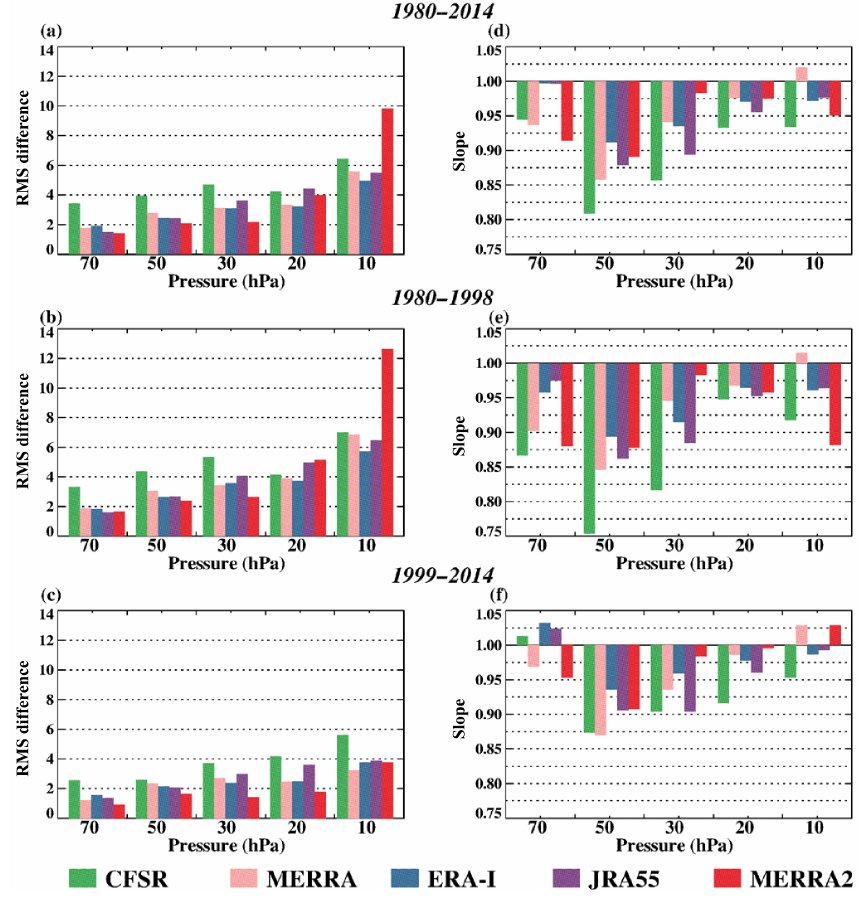
Figure 10. RMS differences (ms − 1 ) (a–c) and linear slopes (d–f) of the matched QBO zonal wind anomalies at 70, 50, 30, 20, and 10hPa for the CFSR, MERRA, ERA-I, JRA-55, and MERRA-2 reanalyses interpolated to Singapore (1 ◦ N, 104 ◦ E) vs. the observed Singapore monthly mean zonal winds from the FUB. RMS differences and slopes are computed for the 1980–2014 time period (a, d) , the 1980–1998 period (b, e) , and the 1999–2014 period (c, f) . Slopes less than 1.0 indicate that the reanalysis zonal winds are weaker than the Singapore zonal